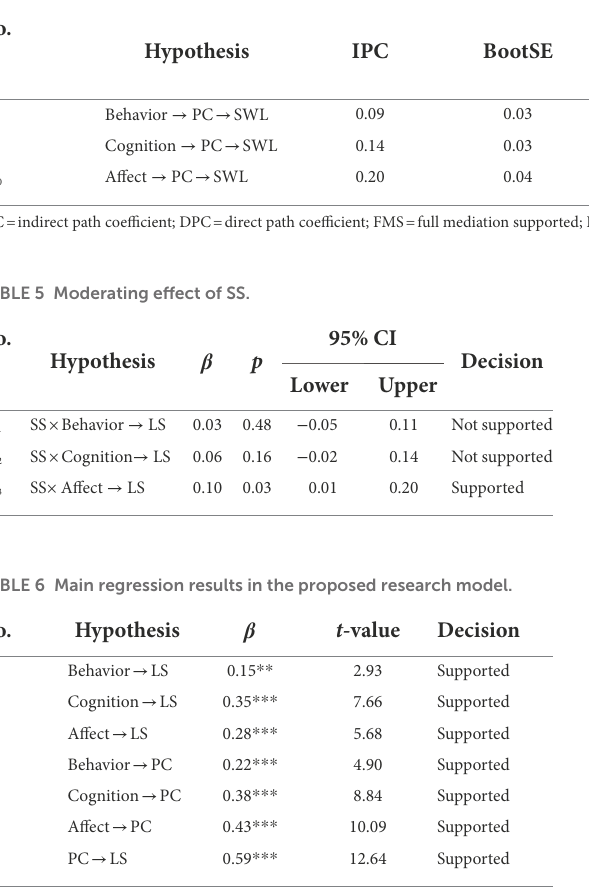
TABLE 4 Mediating effect of